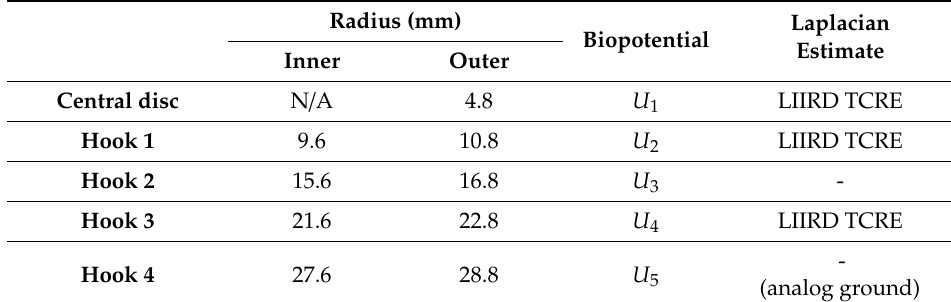
LIIRD: linearly increasing inter-ring distances; TCRE: tripolar concentric ring